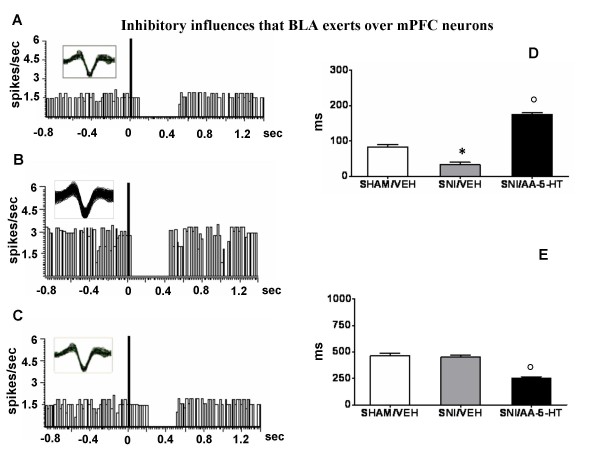
BLA stimulation evokes inhibitory responses in the PL/IL cortex of BLA → PL/IL (-) neurons. The figure shows different parameters of BLA-evoked inhibition, including the onset and duration of the inhibition, in sham and SNI rats treated for 7 days with vehicle (veh) or AA-5-HT (5 mg/kg, i.p.). "A", "B" and "C" show representative ratemater records of a BLA → PL/IL (-) neurons of sham/veh, SNI/veh or SNI/AA-5-HT rat, respectively. "D" and "E" show the onset and duration (mean ± SEM) of the inhibition, respectively, in different groups of rats. * indicates statistically significant difference versus sham/veh and º versus SNI/veh. P < 0.05 was considered as value of significance and n = 10 was used for each group.